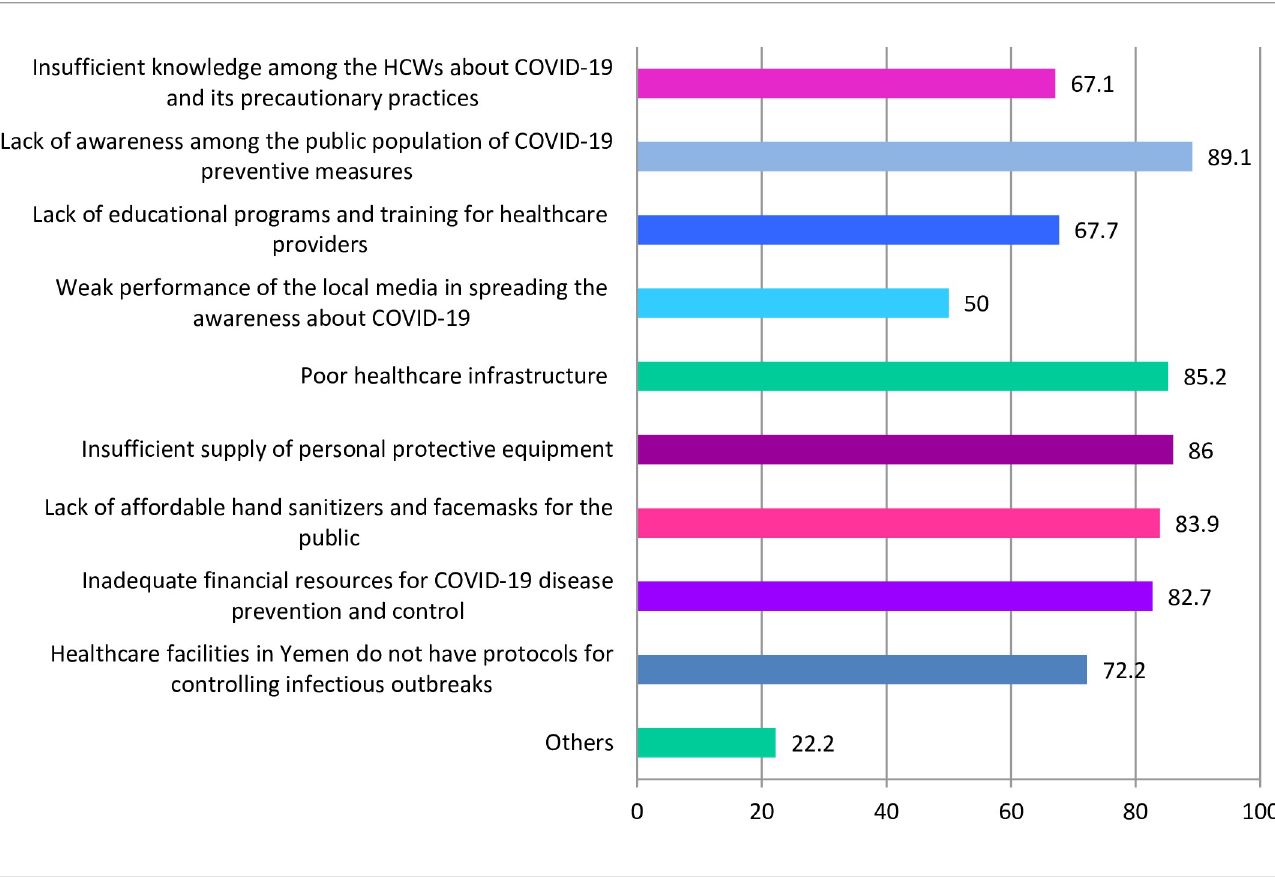
Fig 2. Perceived barriers to adequate prevention and control of COVID-19 in